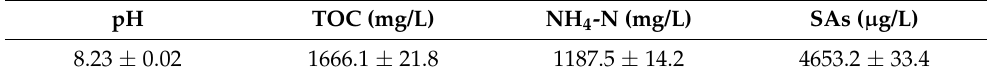
Table 1. The properties of the raw swine wastewater in this study. Data are shown as means ± SD of three replications. TOC—total organic carbon; NH 4 -N—ammonia nitrogen;